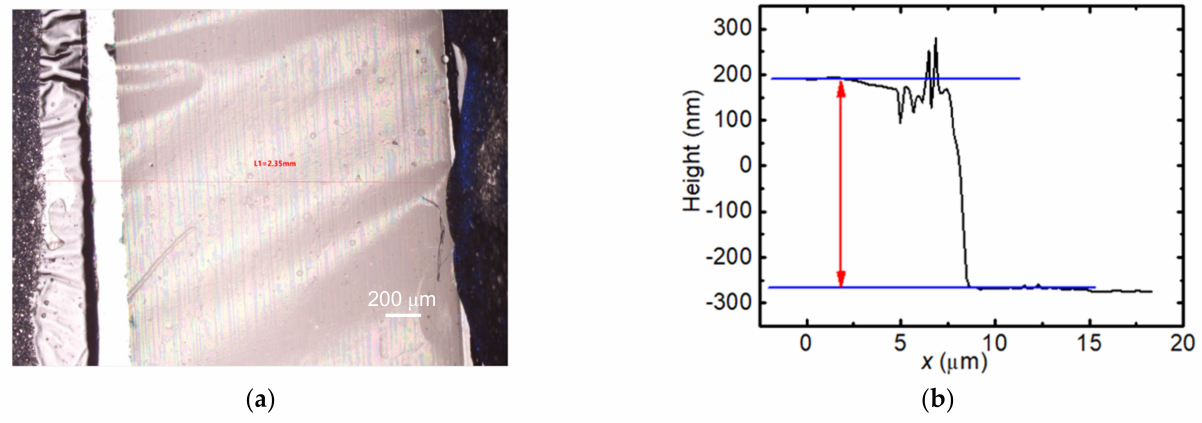
Figure 1. ( a ) Topology of S3 under microscope; ( b ) AFM image of the as-received SLG supported by PMMA.